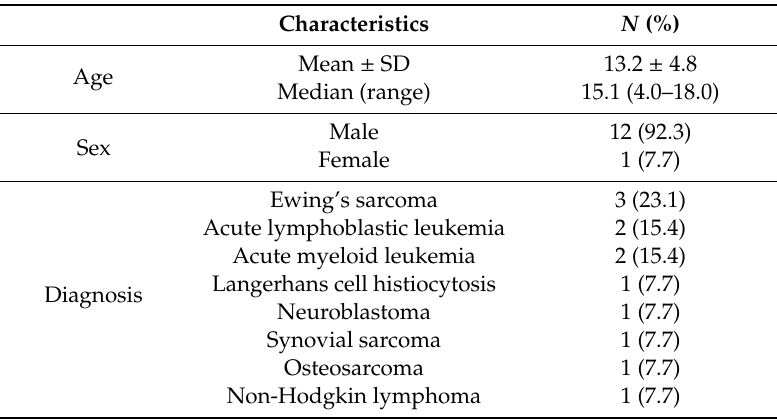
Table 1. Baseline characteristics of